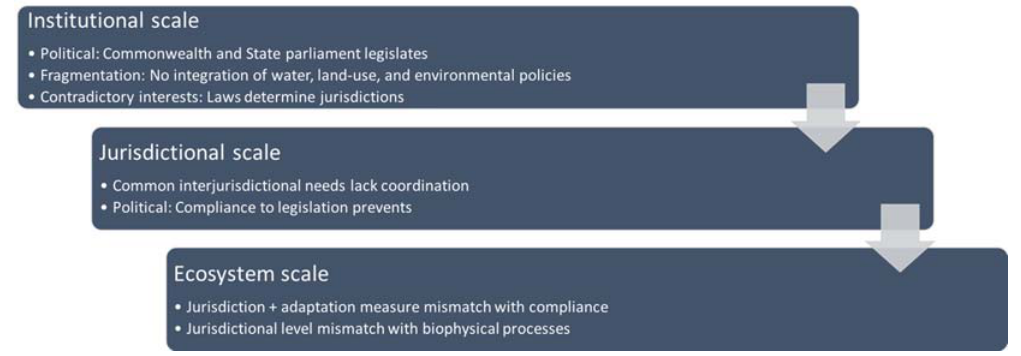
Figure 3. Mismatches across three different scales and the main causes or effects.